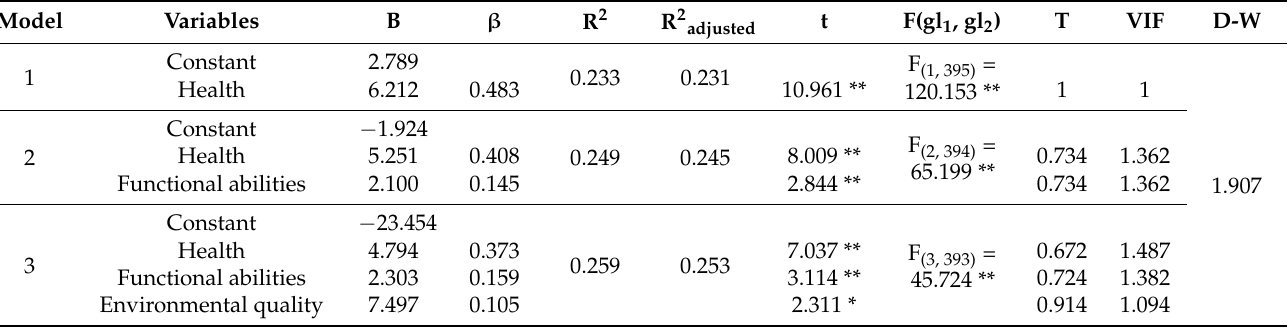
Table 2. Multiple regression analysis (successive stages) of life satisfaction with respect to quality of life and physical activity